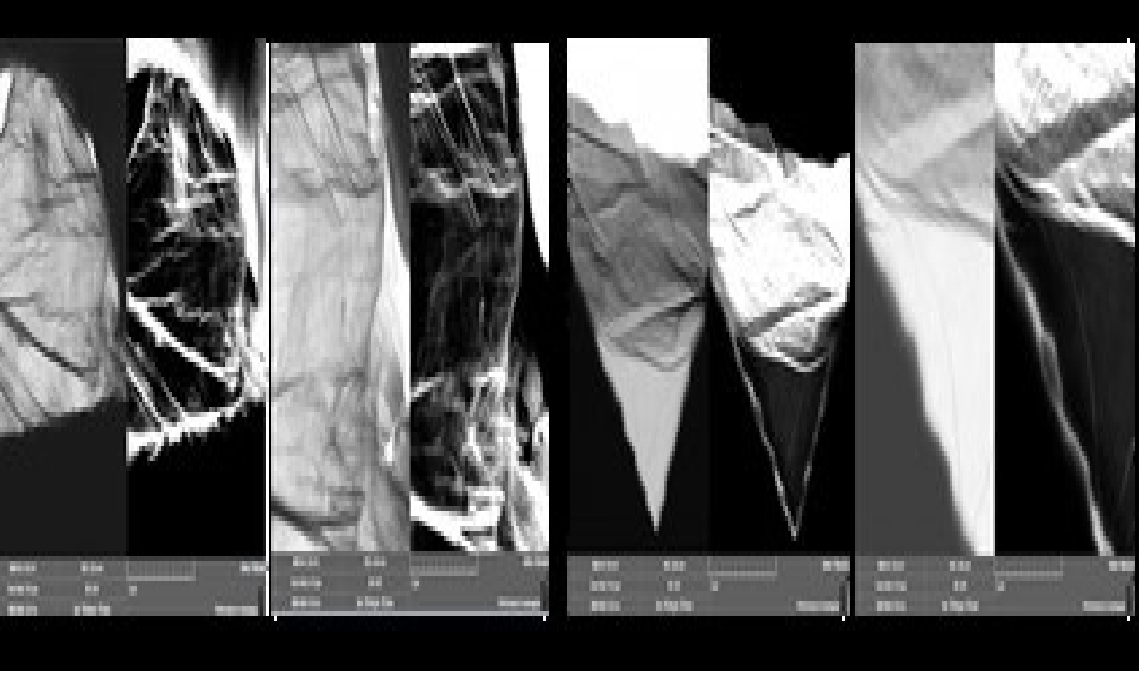
Figure 3: STEM images of 0.05%-1h-50V GO nanosheets at a b ) 20.00 kx and b ) 50.00 kx 1 2